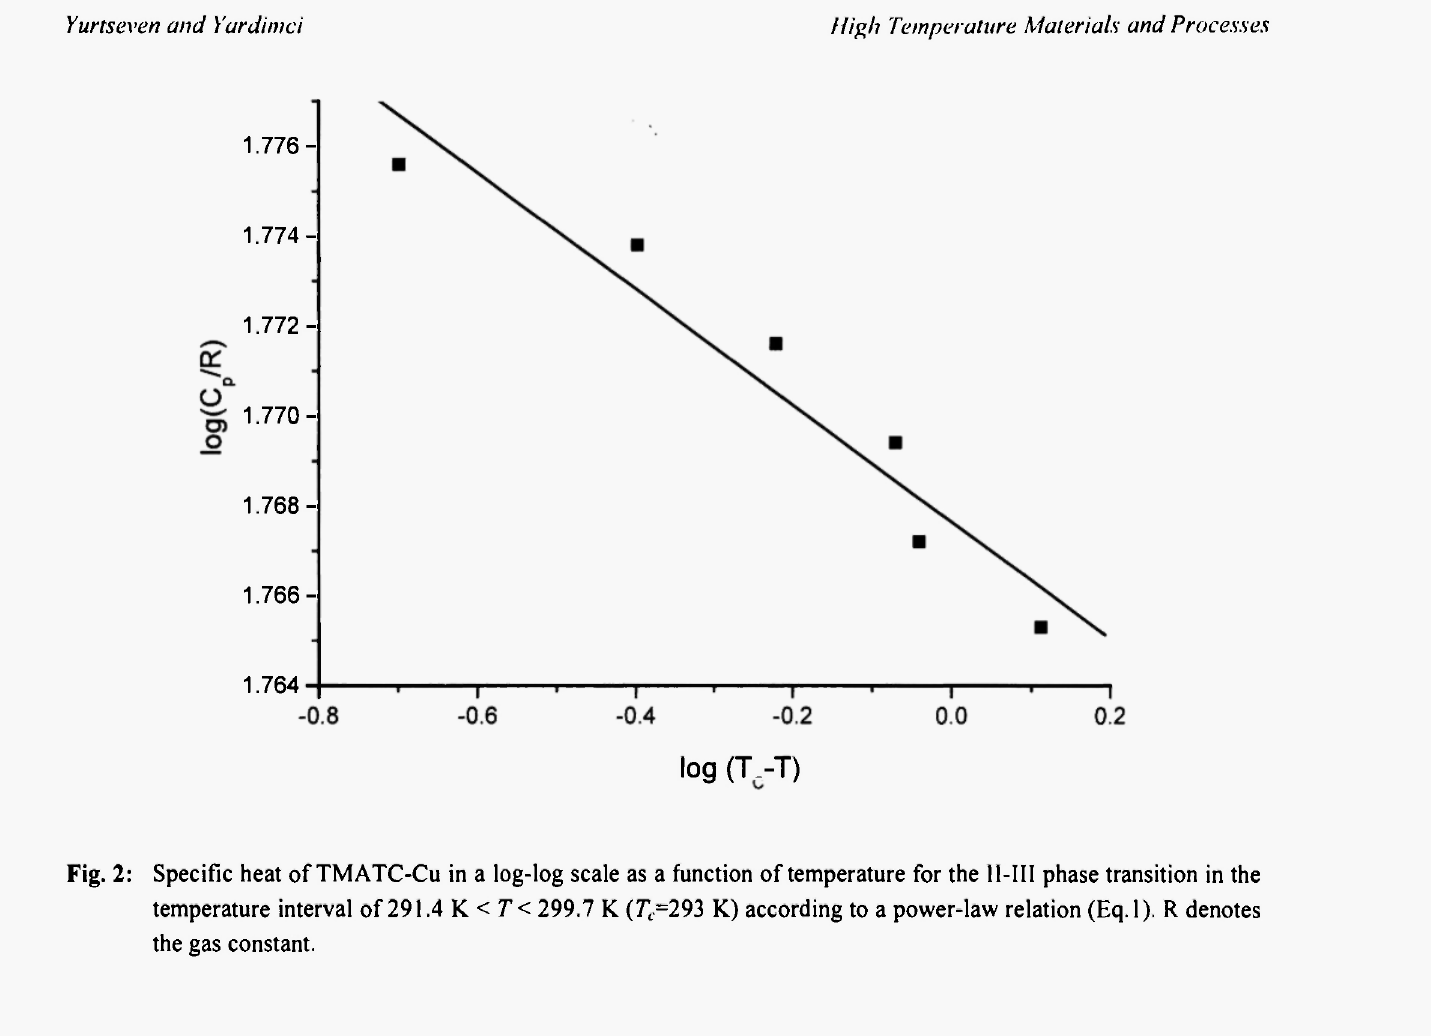
Fig. 2: Specific heat of TMATC-Cu in a log-log scale as a function of temperature for the 11-111 phase transition in the temperature interval of 291.4 Κ < Τ < 299.7 Κ (7>=293 Κ) according to a power-law relation (Eq.l). R denotes the gas